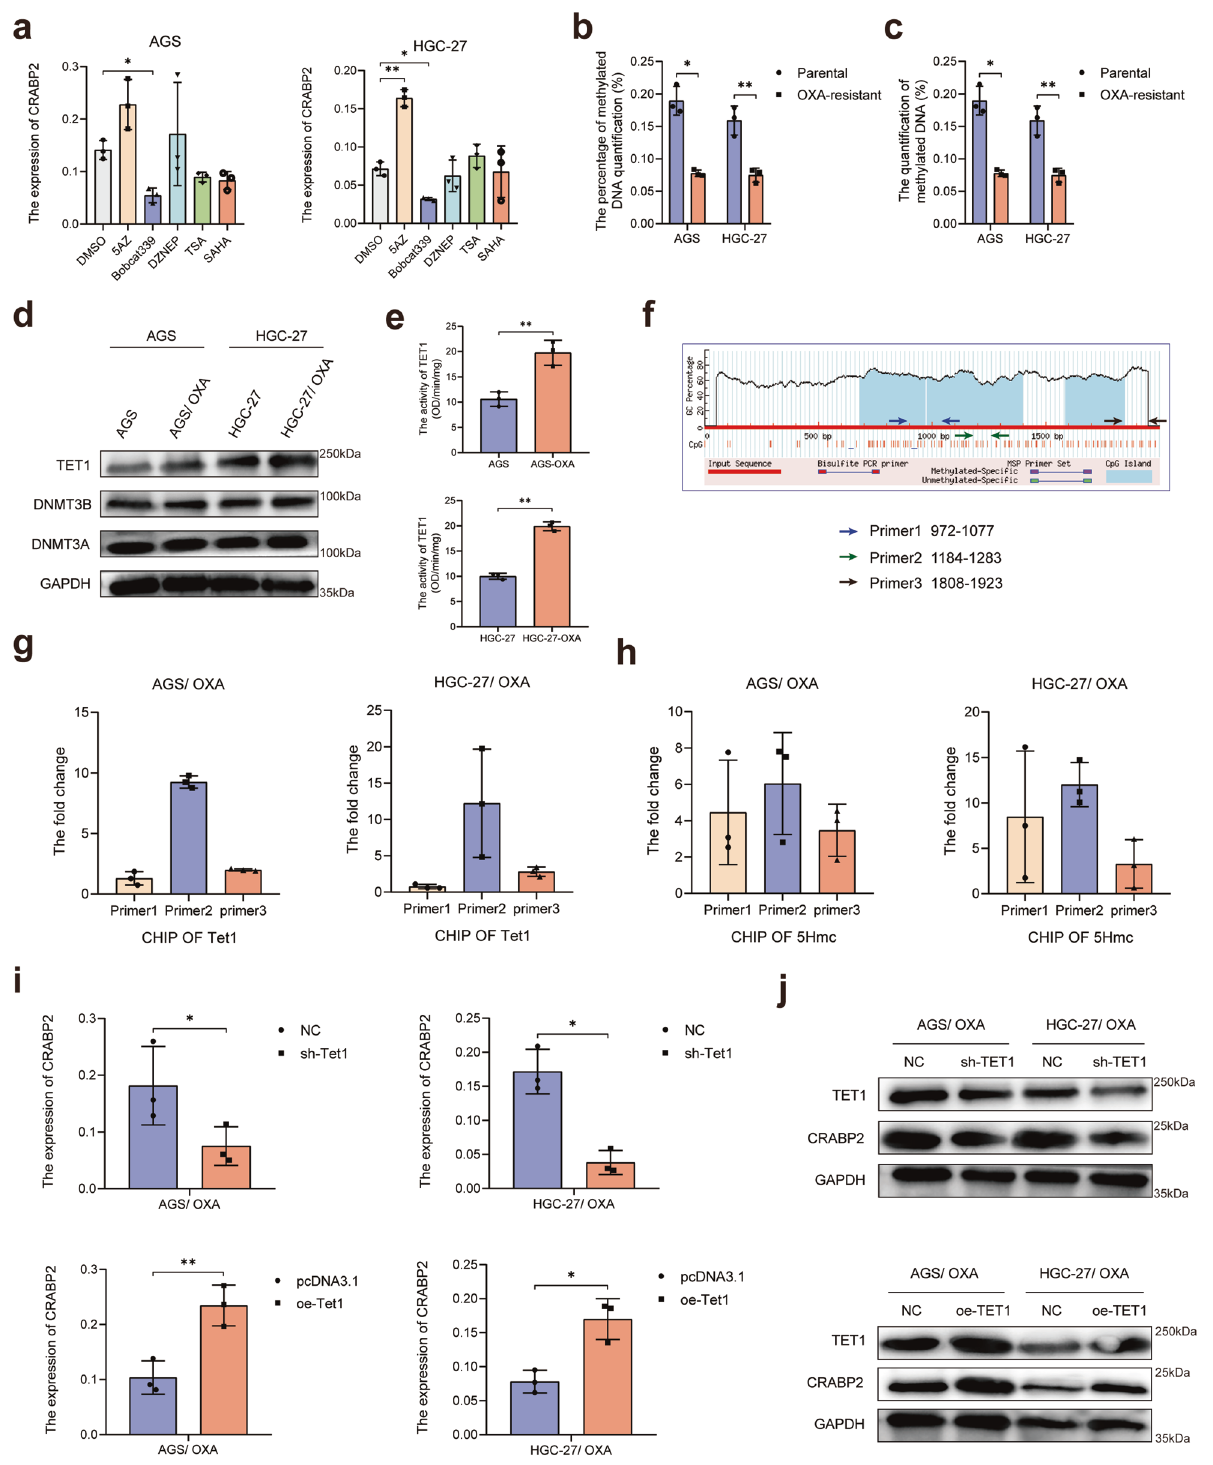
Fig. 6 TET1-mediated DNA hydroxymethylation expedited the expression of CRABP2. a After adding 5AZ, Bobcat339, DZNEP, TSA, or SAHA to AGS and HGC-27 cells, the mRNA expression changes in CRABP2 were detected. The methylation ( b ) and hydroxymethylation ( c ) levels of OXA-resistant GC cells and parental GC cells were examined. d The expression and activity of DNA methylase, demethylase, and hydroxymethylase from OXA-resistant and parental GC cells were examined by western blotting. e The activity of hydroxymethylase TET1 was detected in OXA-resistant GC cells and parental GC cells. f Schematic diagram of the predicted and designed methylation sites in the promoter region of CRABP2. g ChIP experiments using a TET1 antibody were performed in OXA-resistant GC cells. h Hydroxymethylated ChIP assays were performed in OXA-resistant GC cells. After knocking down or overexpressing TET1 in OXA-resistant GC cells, the expression of CRABP2 was examined by qRT – PCR ( i ) and western blotting ( j ). * P < 0.05, ** P < 0.01, *** P < 0.001, ns not signi fi cant.